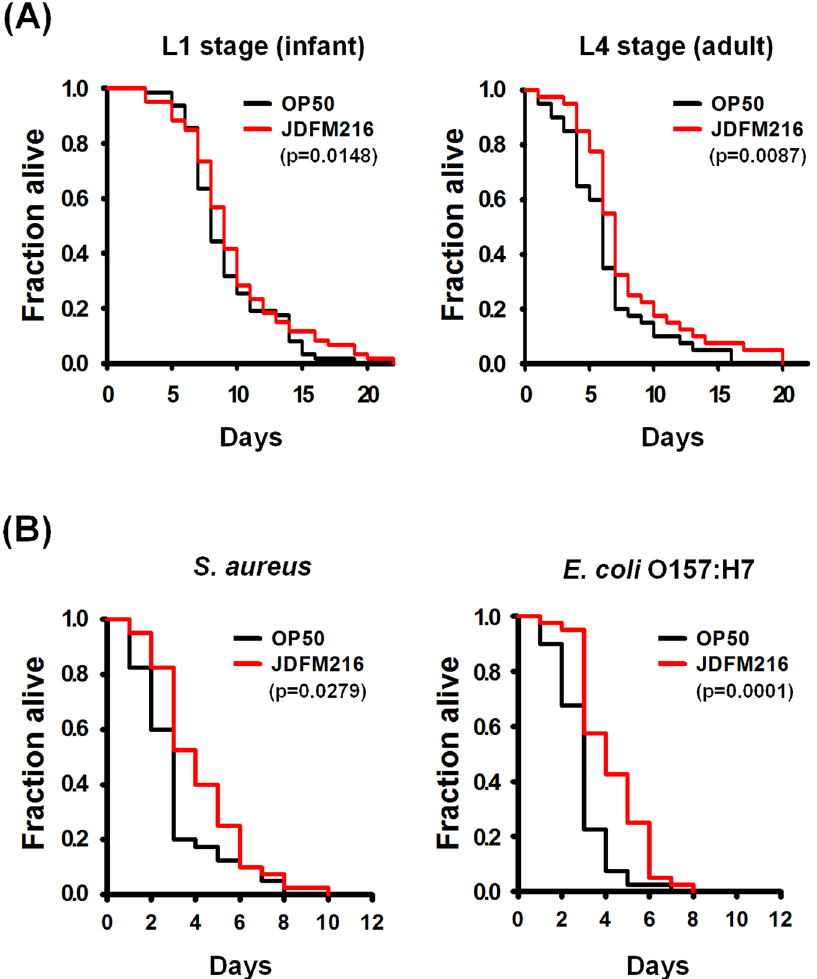
Figure 1. ( A ) Enhanced lifespan of C. elegans fer-15;fem-1 via conditioning with Lactobacillus fermentum strain JDFM216 for 24 h prolonged the lifespan of C. elegans nematodes. Survival statistics: p = 0.0148 for L1 stage (left), and p = 0.0087 for L4/young adult stage (right) of nematodes compared with worms feeding on the E. coli OP50 control strain (n = 30 per plate). ( B ) Immune stimulation of C. elegans via pre-conditioning with JDFM216 for 24 h prolonged the lifespan of C. elegans strains, N2 wild-type or pmk-1 mutant infected with S. aureus strain RN6390. Survival statistics: p = 0.0026 for 1 day, p = 0.0492 for 3 days, p = 0.0000 for 6 days, and p = 0.0103 for 9 days conditioned nematodes compared with worms feeding on the E. coli OP50 control strain (n = 30 per